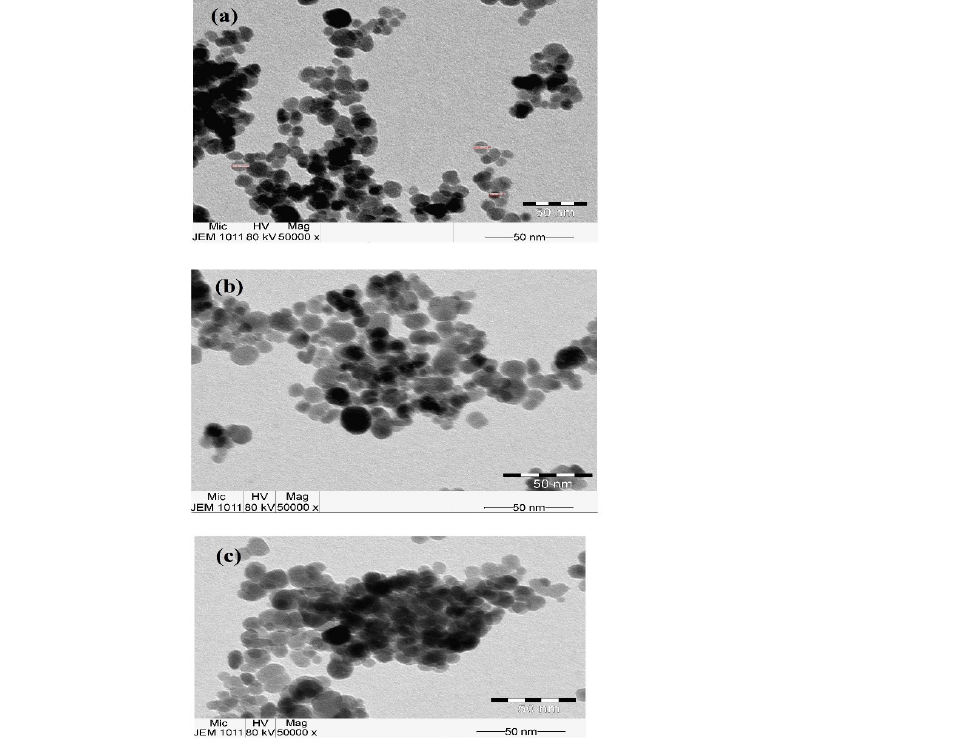
Figure 6. TEM micrographs of Ag capped with ( a ) EOA, ( b ) ELOA and ( c ) ELNA.